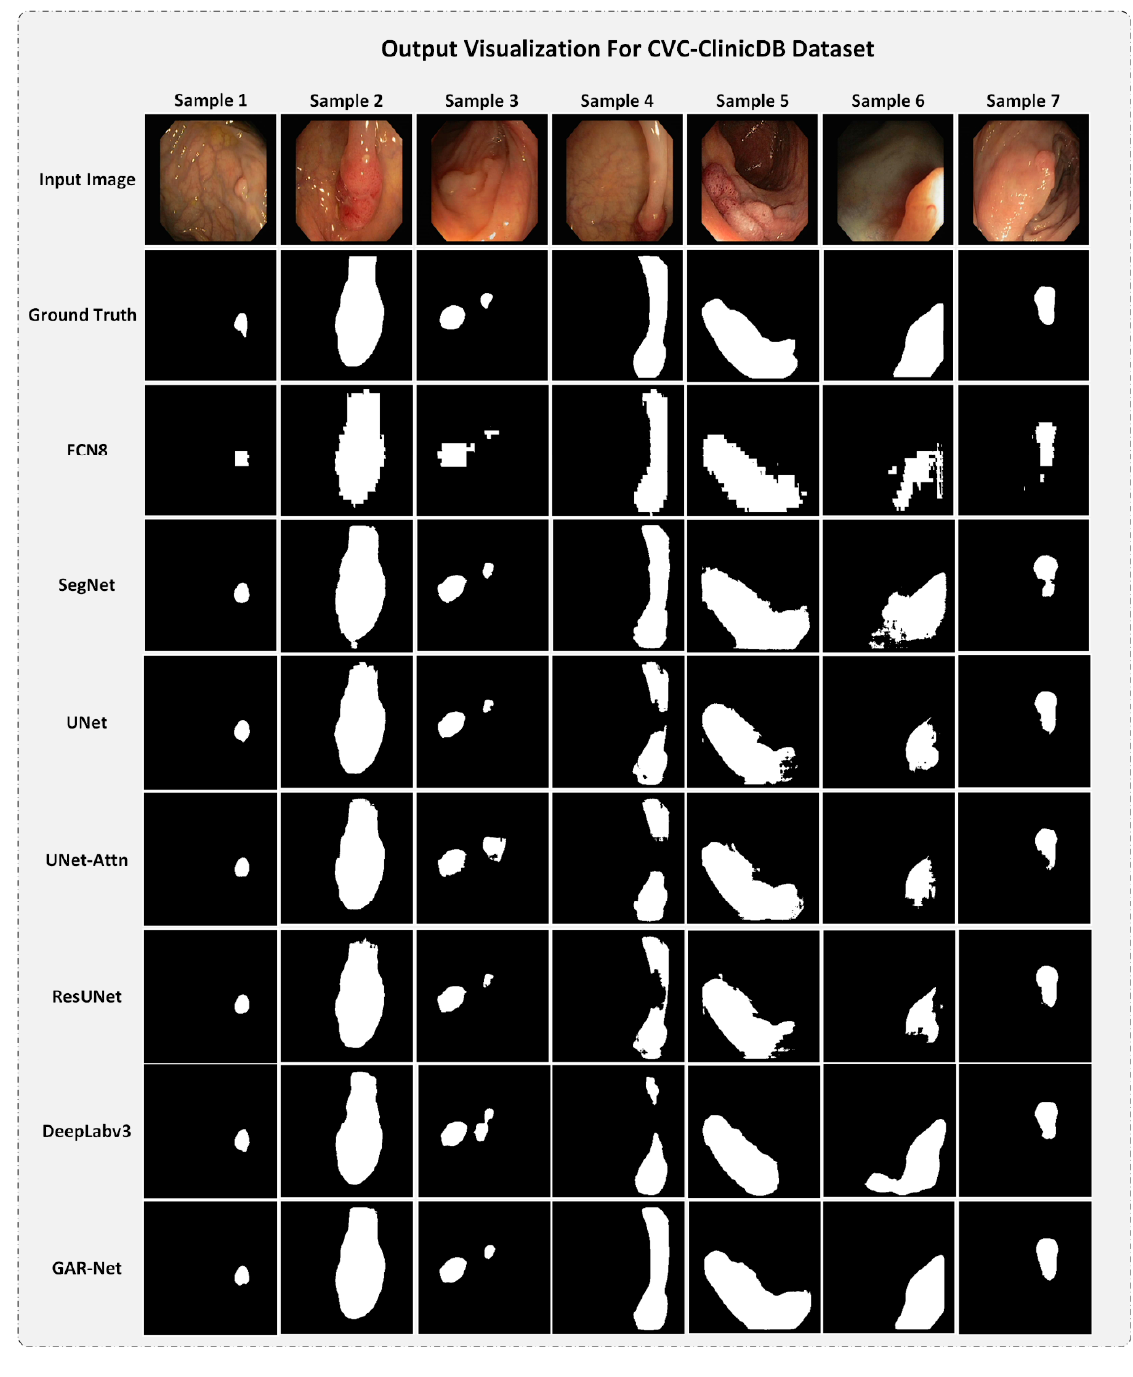
Figure 7. The output comparison for all the models on the CVC-ClinicDB Dataset.